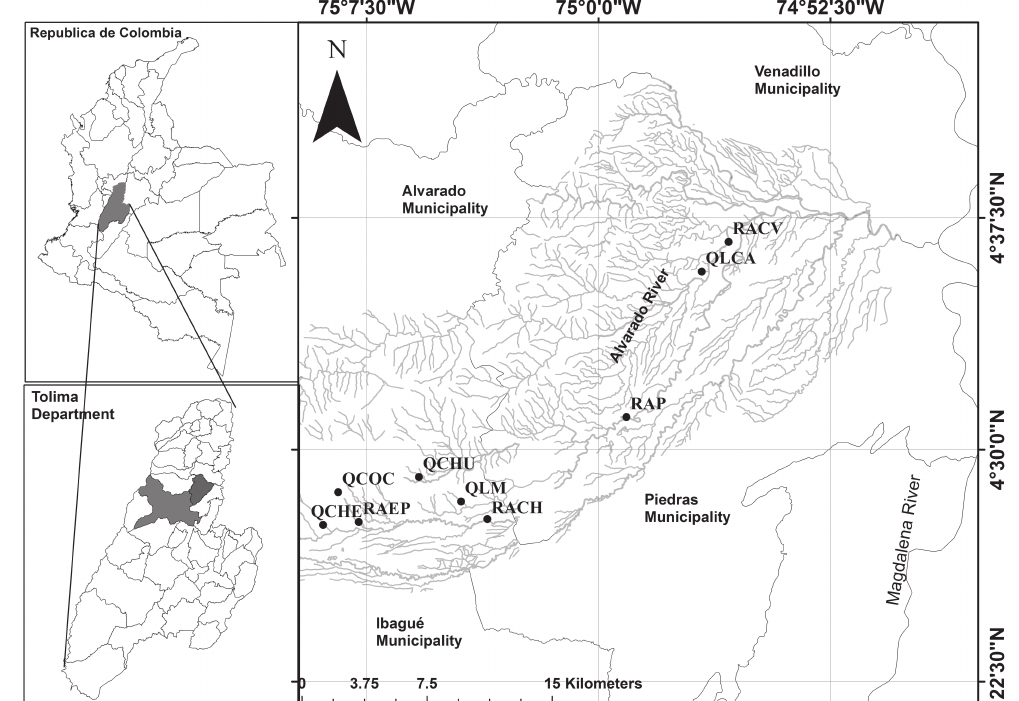
Fig. 1. Study area with the sampling stations in the trans-Andean Alvarado River drainage, Upper Magdalena River Basin, Colombia: QCOC, Quebrada Cocare; QCHE, Quebrada Chembe; QCHU, Quebrada Chumba; RAEP, Alvarado River (El País); QLM, Quebrada La Manjarres; RACH, Alvarado River (Chucuni); RAP, Alvarado River (El Puente); QLCA, Quebrada La Caima; RACV, Alvarado River (Caldas